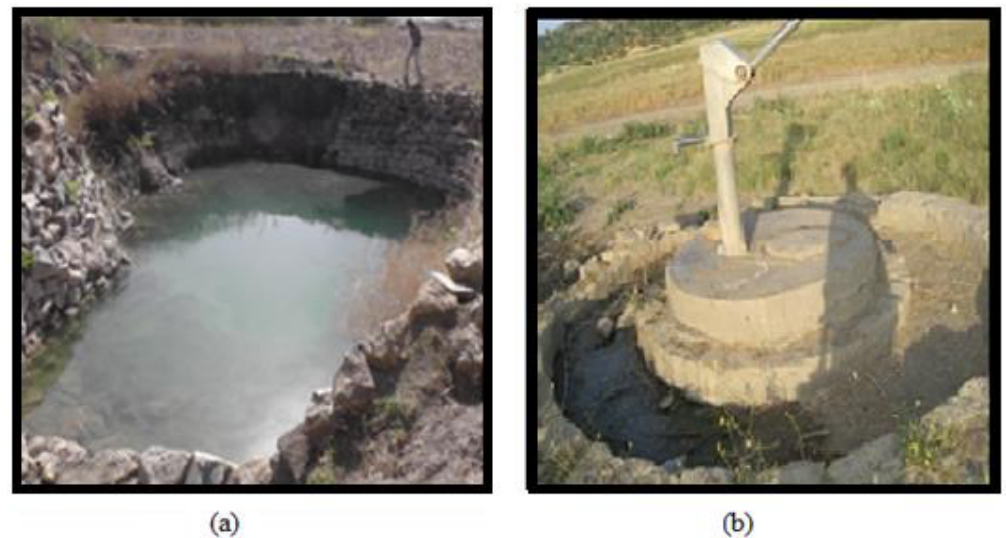
Figure 5. Some of the existing opened hand-dug well ( a ) and closed hand dug well ( b ) in the effective watershed area.